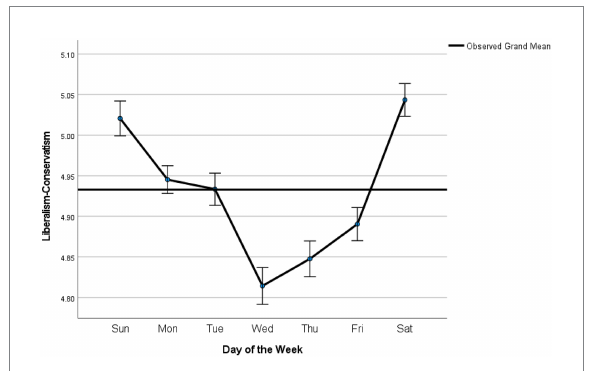
FIGURE 2 Weekly fluctuation patterns of liberalism-conservatism. The error bars show the 95%